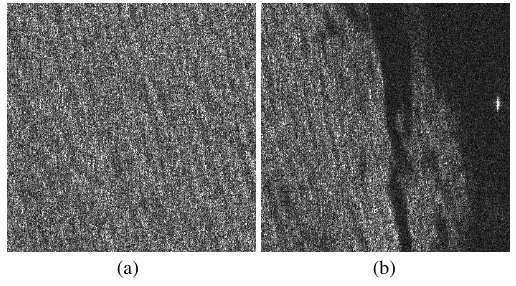
Figure 2. Mean-square error of the roughness parameter ( ↵ ) Figure 3. Mean-Square Error of the scale parameter (  ) estimates. The solid line refers to FMoLC and the dot line to estimates. The solid line refers to FMoLC and the dot line to MoLC. MoLC. the roughness and scale parameters of the G 0 I distribution were estimated by using these estimation methods. Inspired by (Me- jail et al., 2003), we estimated the parameters for each image pixel by applying a sliding window of 5x5 pixels and using both estimation methods on real SAR images. Fig. 4 presents mul- titemporal intensity SAR images acquired by ALOS/PALSAR (L-band, 1 look and HH channel) over the Campos Basin on the Southern Brazilian coast, via two consecutive acquisitions.